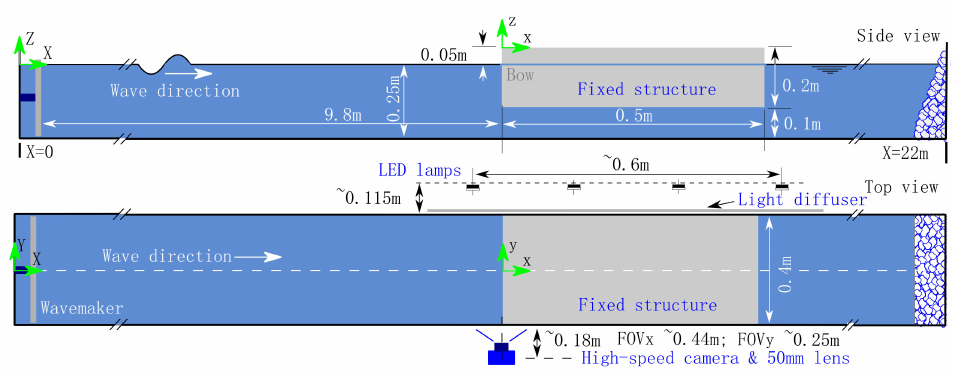
Figure 2. ( Side ) and ( top ) views of the experimental